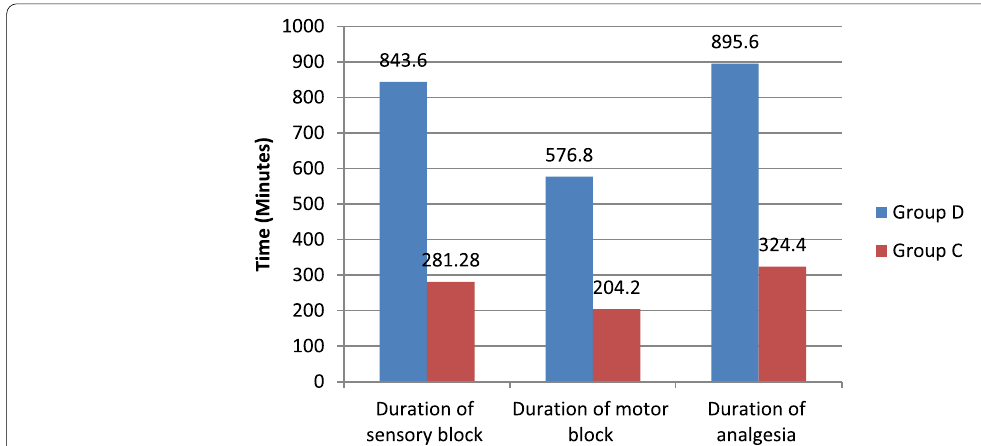
Fig. 2 Duration of sensory block, motor block, and analgesia